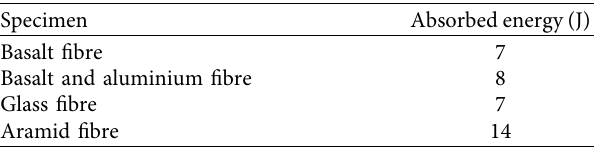
Figure 6: Impact testing of the sample specimen. Table 3: Experimental values of absorbed energy using the impact